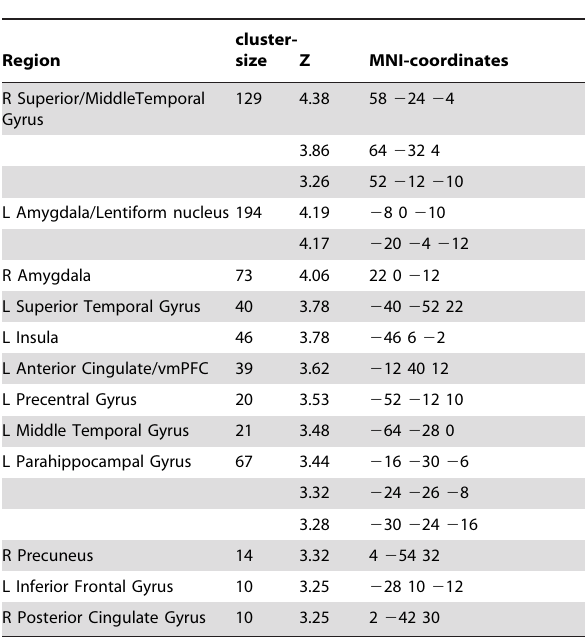
Table 1. Anatomical Site, Cluster Size, maximum Z value, and MNI coordinates of the local maxima for the connectivity analysis (seed in left ventral striatum [MNI coordinates 2 10 9 2 9], connectivity gamblers . controls).